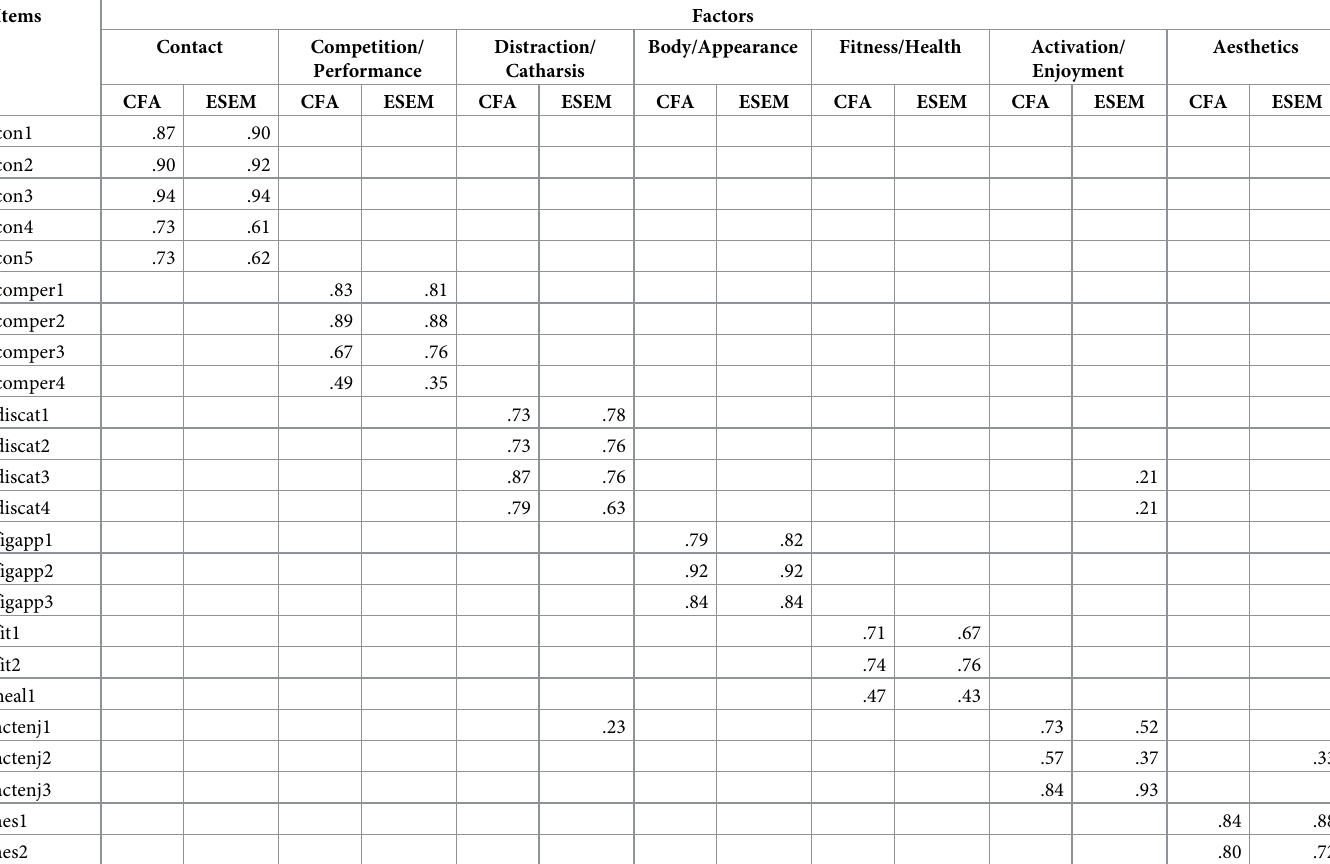
Table 3. Factor loadings of the original BMZI in sample